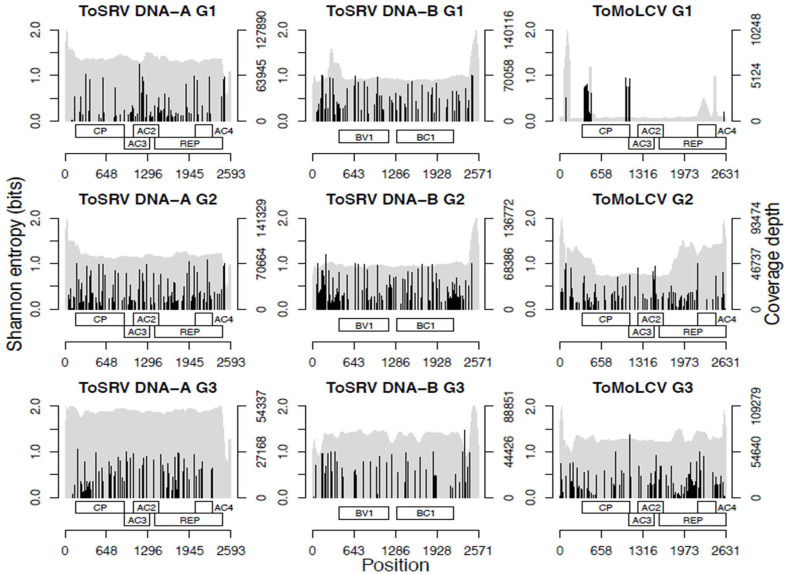
Nucleotide diversity analysis of ToSRV and ToMoLCV showing coverage depth (gray) and Shannon entropy for the SNPs (black) and a representation of genome organization.